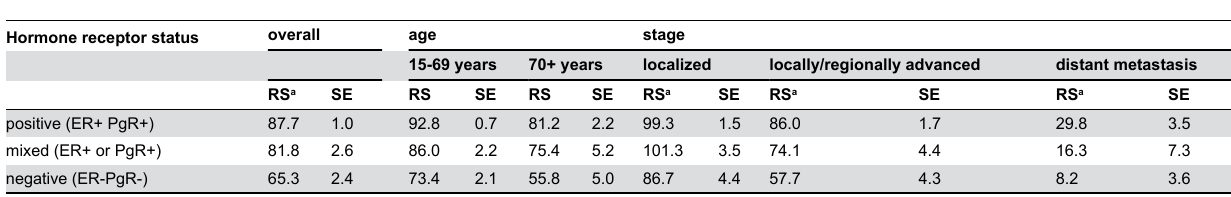
Table 5. Five-year relative survival of female patients from Saarland with invasive breast cancer (ICD-10 code: C50) by hormone receptor status and stratified by age and stage estimated for the calendar period 2005-2009 based on completed datasets.